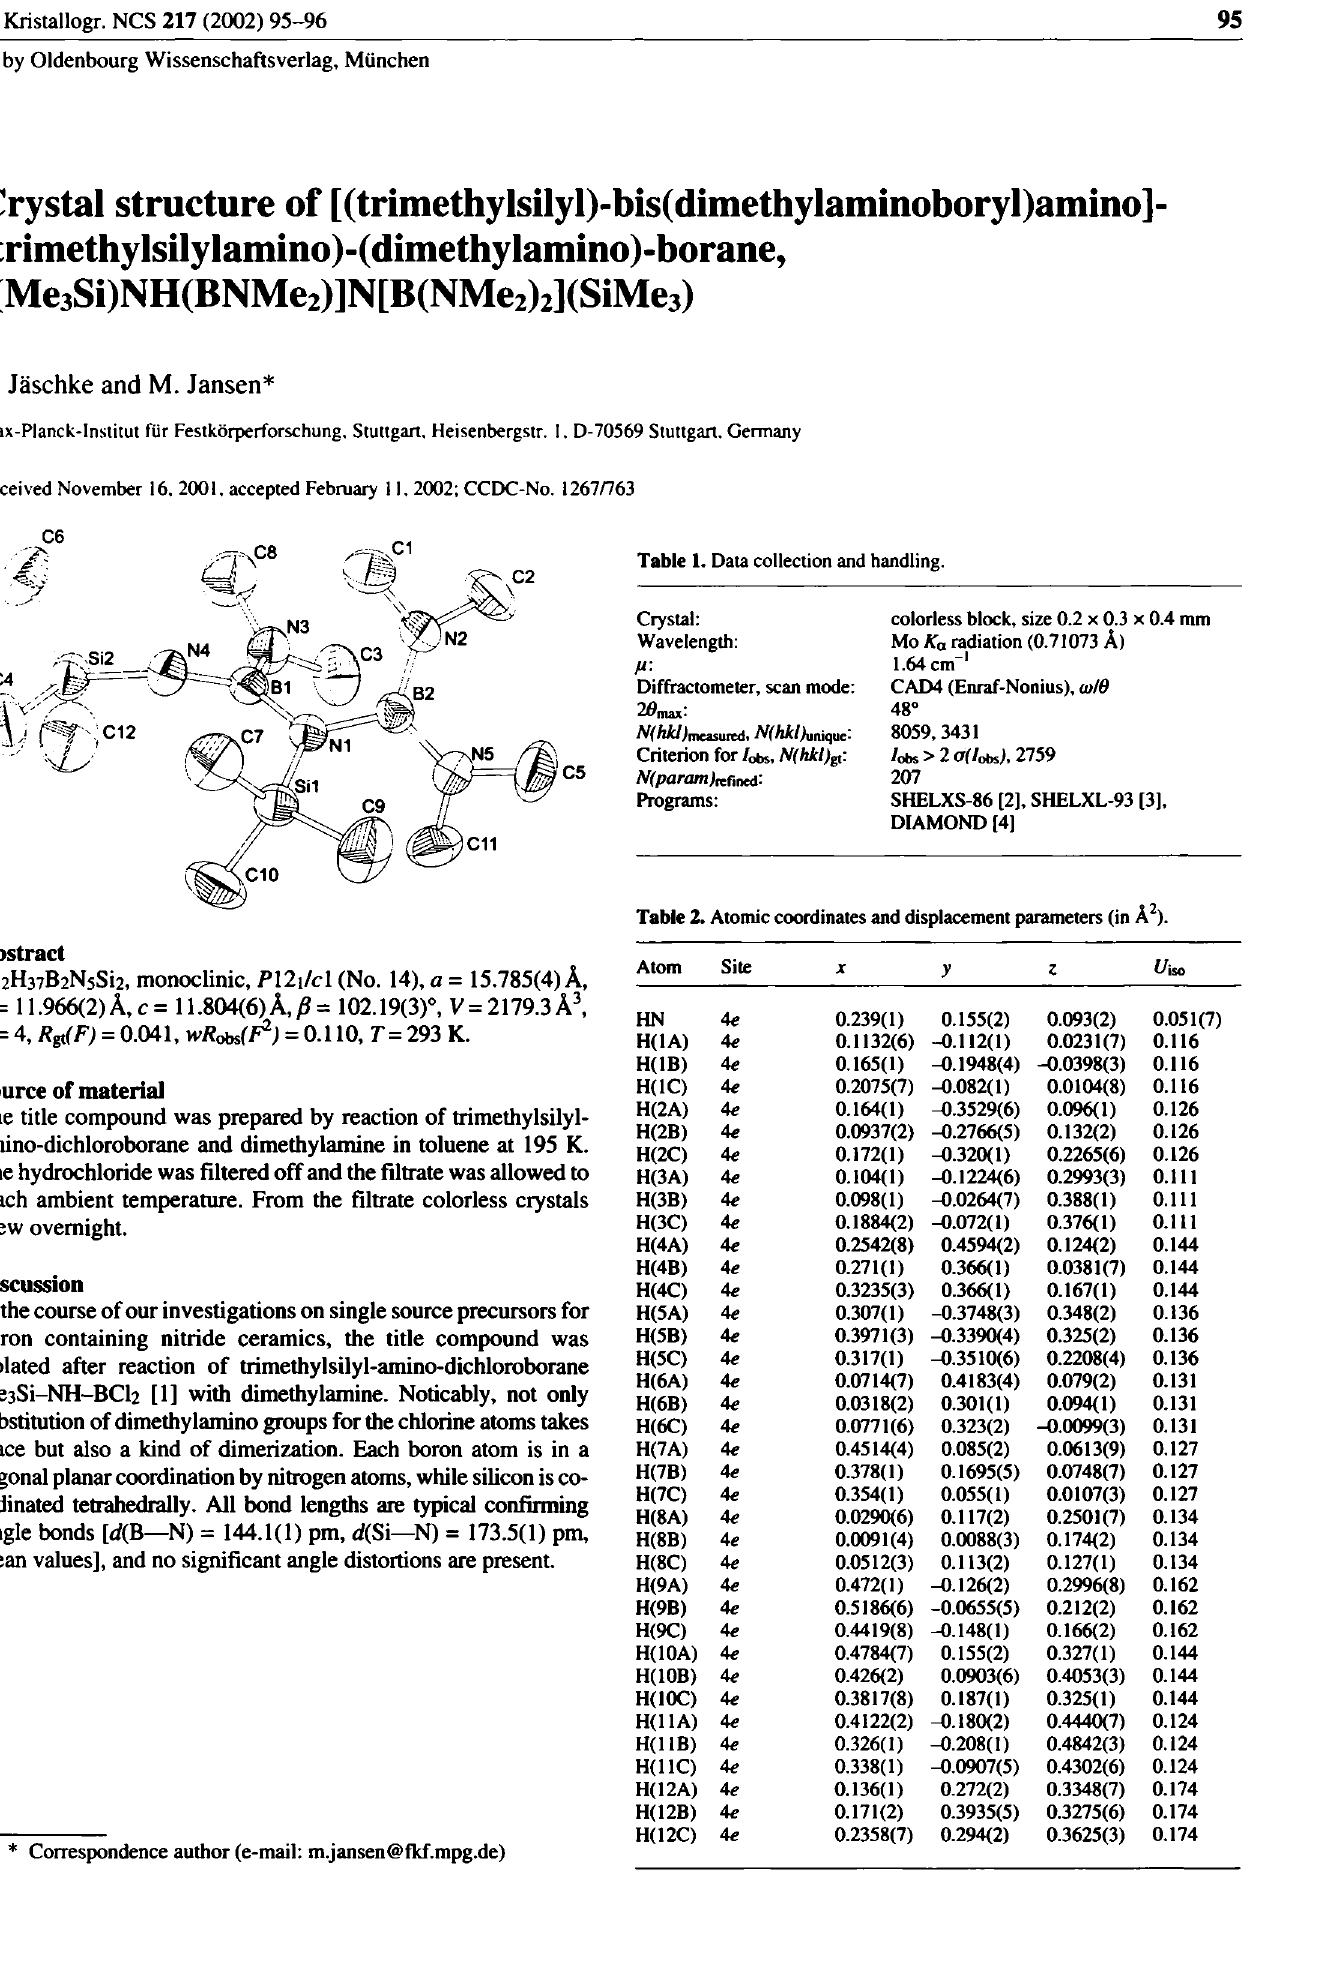
Table 1. Data collection and handling.